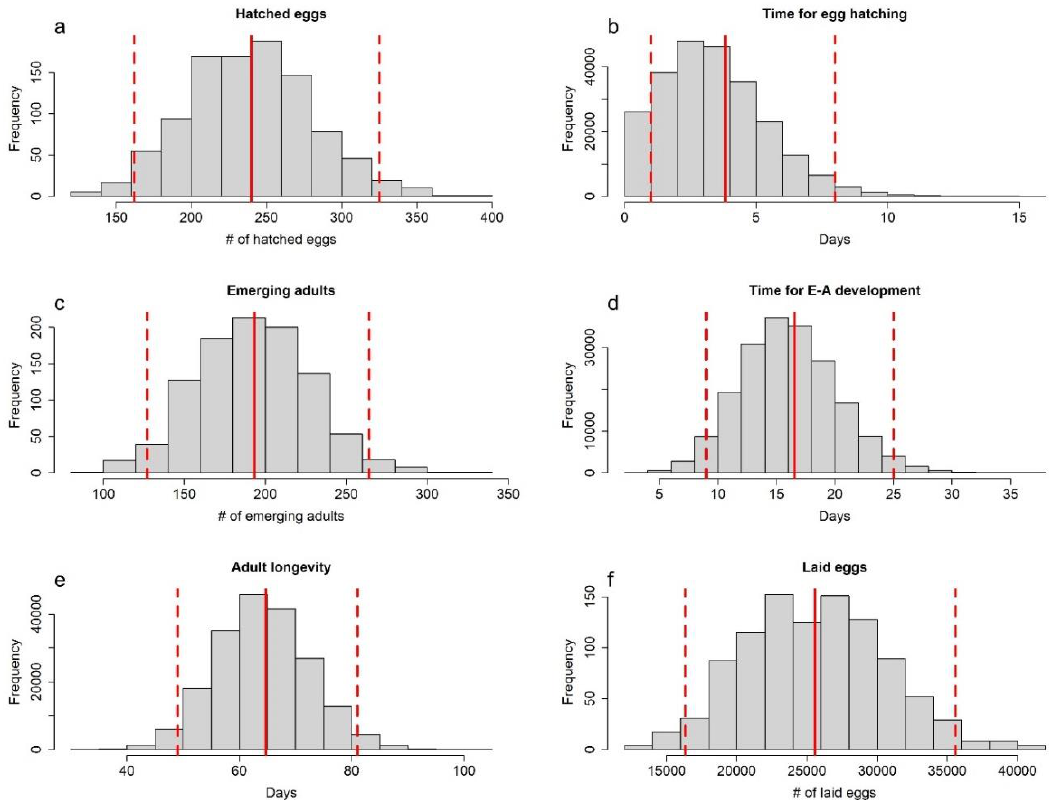
Figure A9. Distributions of quantities of interest for simulated (1000 simulations) life history of 1000 initial eggs at 25 °C. ( a ) Number of hatched eggs; ( b ) time for egg development; ( c ) number of emerging adults; ( d ) time of development from the egg stage; ( e ) adult longevity; ( f ) total number of eggs laid by all females. Dashed red lines represent the 2.5 and 97.5 quantiles, solid red lines represent the average value.